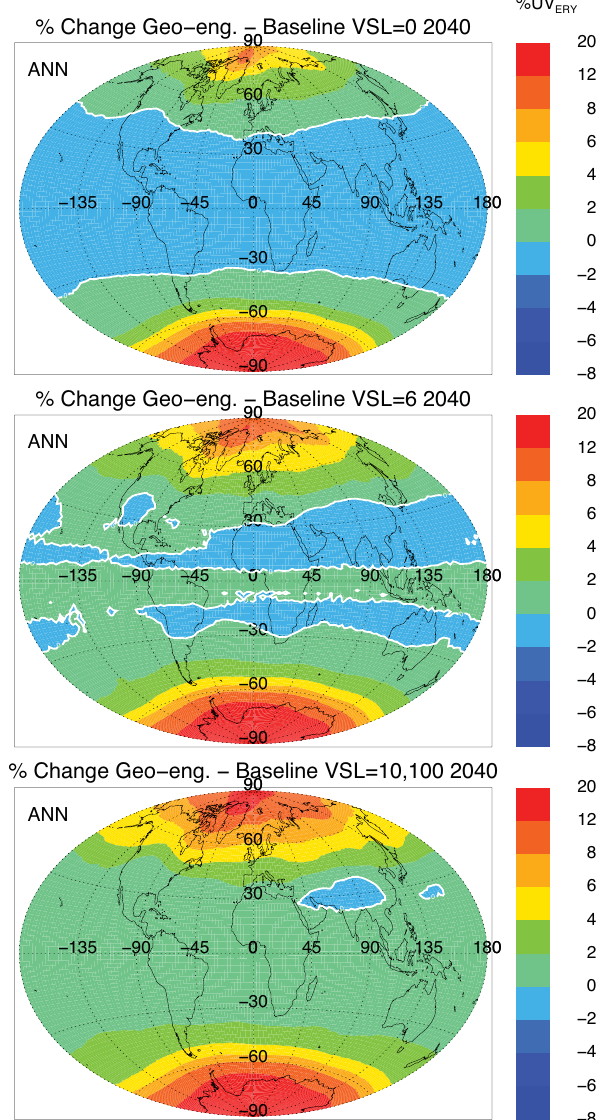
Fig. 3. Relative changes of UV radiation weighted for human ery- thema (skin-reddening) due to geo-engineering, for projected chem- ical conditions in year 2040. Changes are the result of differences in column ozone between the geo-engineering and the baseline sim- ulation. The additional amount of stratospheric bromine from VSL halogens is assumed to be zero (top) and Br VSL y = 6ppt (middle) and Br VSL y = 10ppt, Cl VSL y = 100ppt (bottom). The white line rep- resents the zero